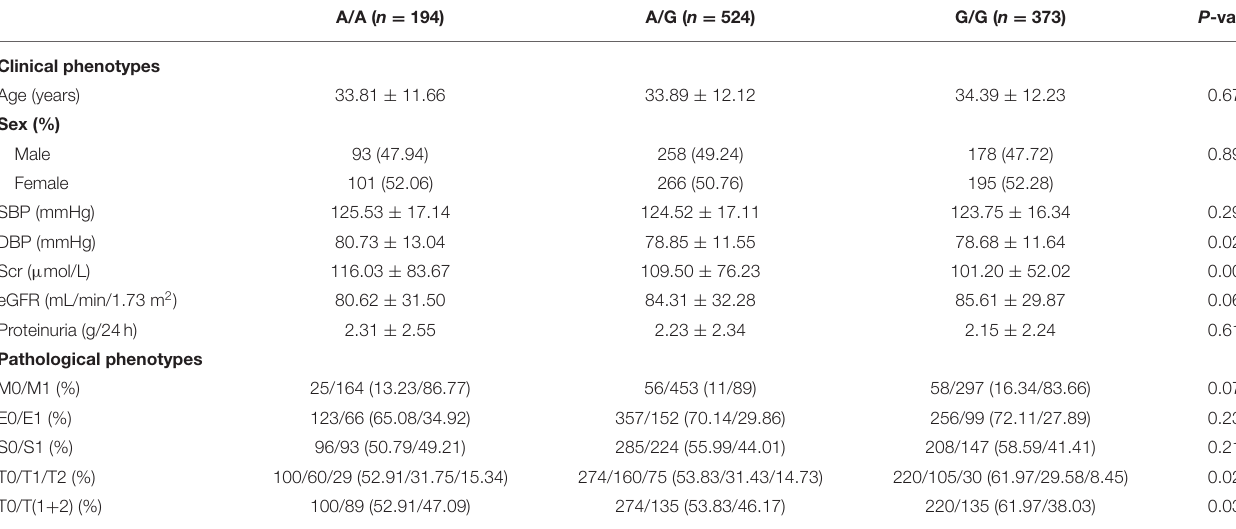
TABLE 3 | Association of rs3093023 genotypes with IgAN